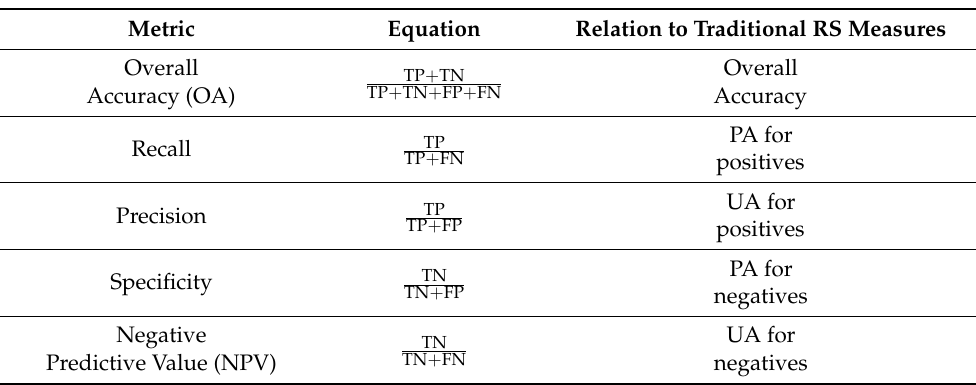
Table 3. Binary assessment metrics and relationships to traditional accuracy assessment